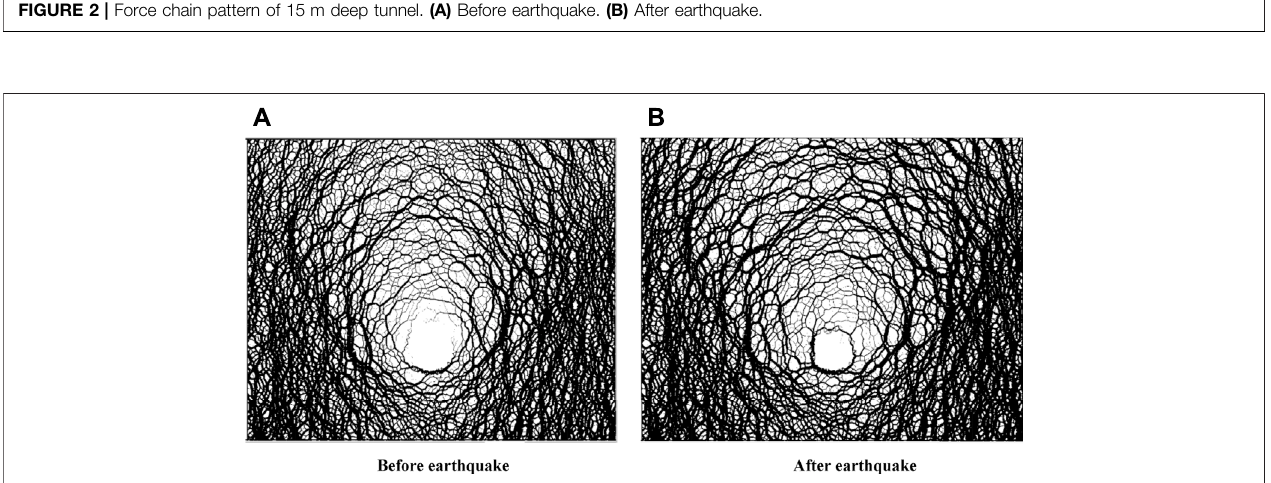
FIGURE 3 | Force chain pattern of 25 m deep tunnel. (A) Before earthquake. (B) After earthquake.